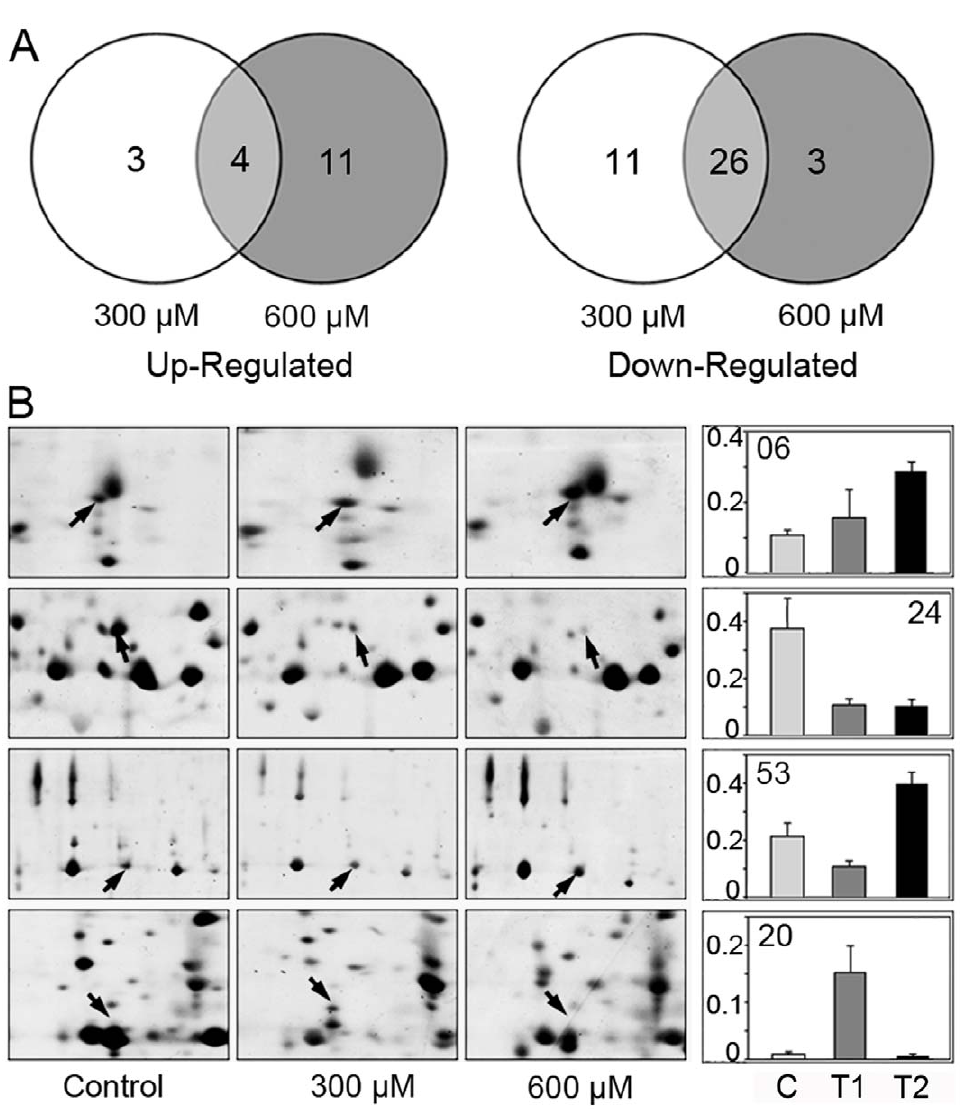
Figure 3. Change profile of the differentially expressed protein spots. (A) Venn diagram analysis of the differentially expressed protein spots in the apoplast of rice seedling roots treated with 300 m M and 600 m M H 2 O 2 . The number of differentially expressed protein spots with up- (left panel) or down-regulation (right panel) under a given concentration of H 2 O 2 are also shown. (B) Typical examples of spSots showing different profiles.